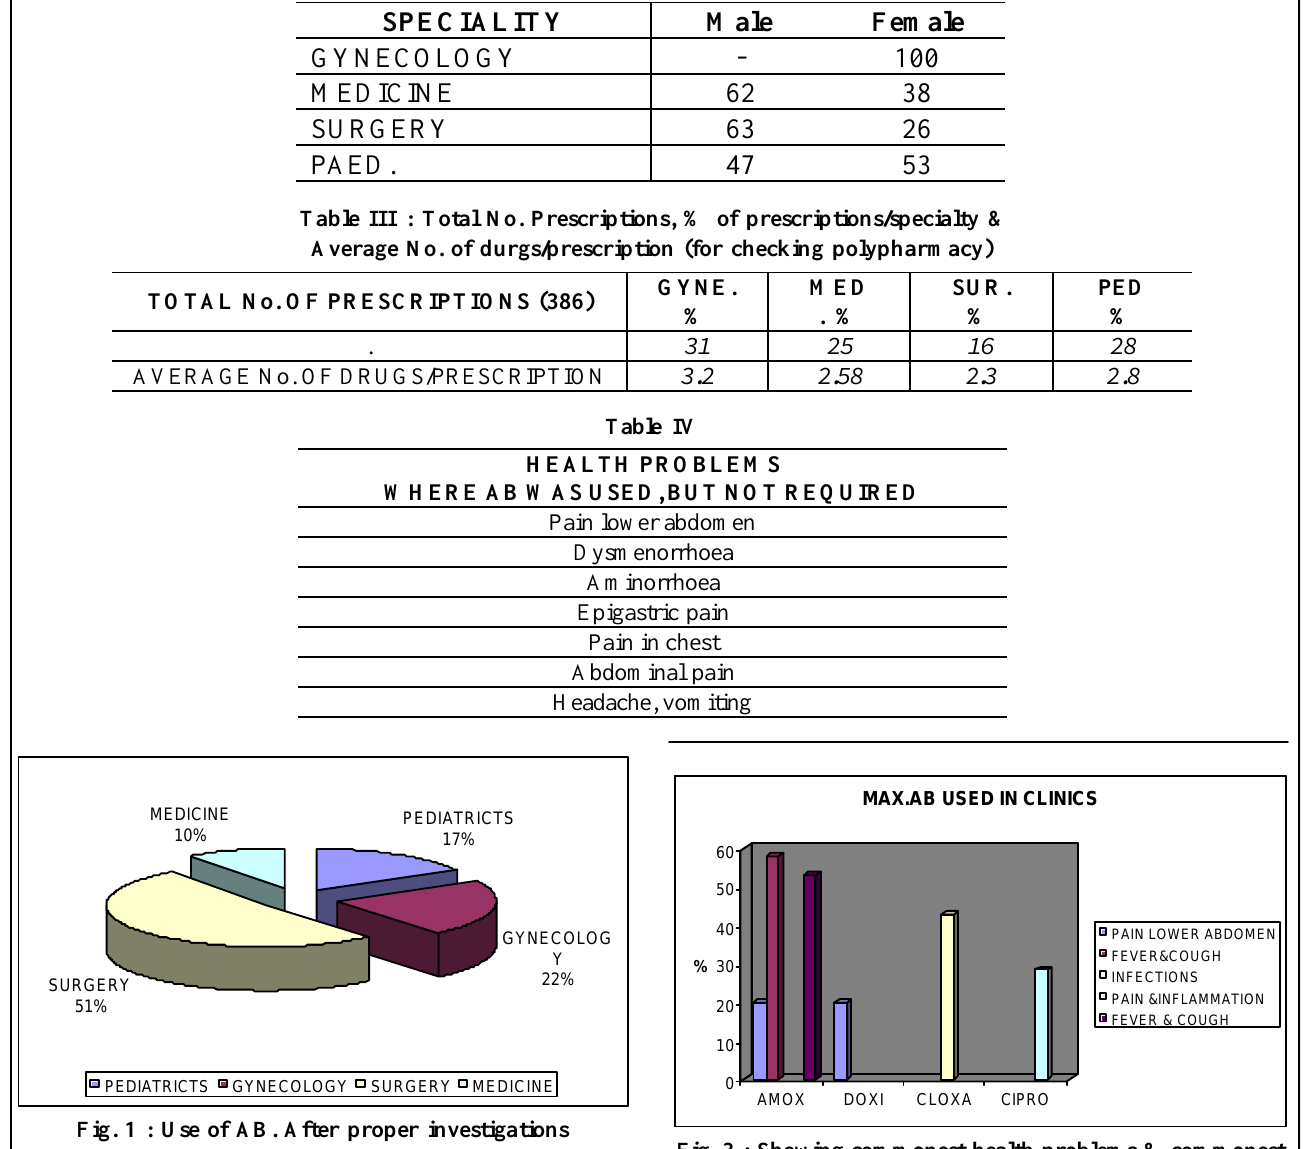
Fig. 3 : Showing commonest health problems & commonest AB used in different specialities in